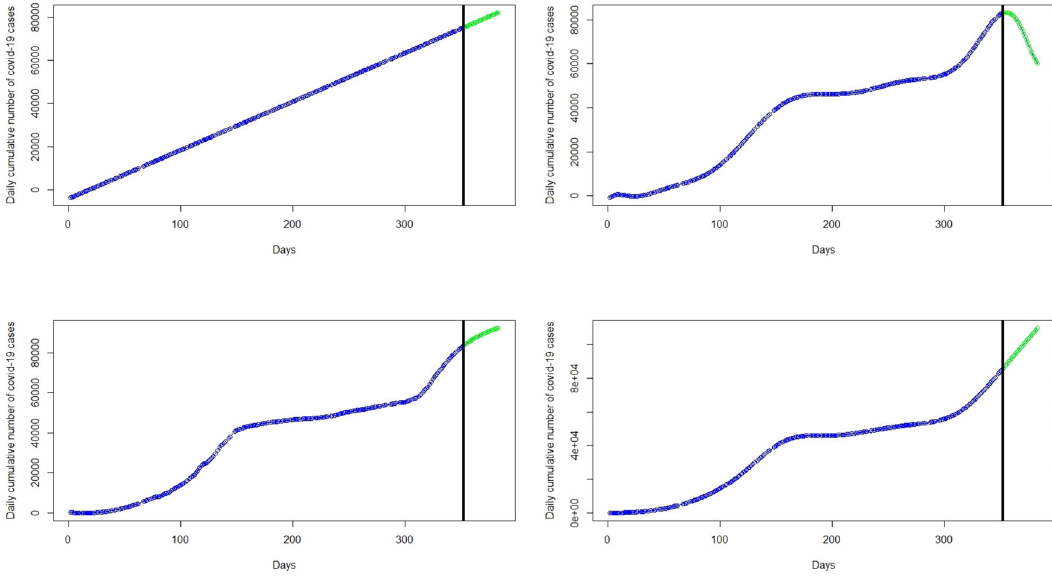
Figure6.Plotsoftheobserveddatavalues(bluemarkerdots)andforecasts(greenmarkerdots)ofcumulative coronavirus disease 2019 (COVID-19) cases using linear regression (top-left panel), polynomial regression (top-right panel), spline regression (bottom-left panel), and generalized additive model (bottom-right panel).